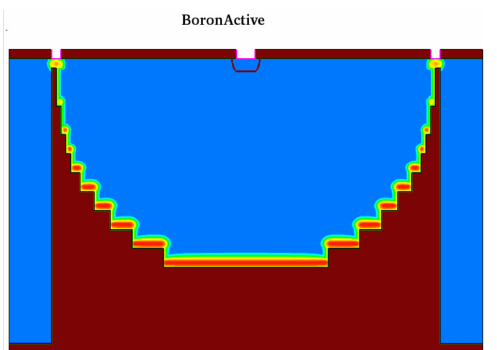
Figure 13. The simulation result of the hemispherical/near-hemispherical electrode